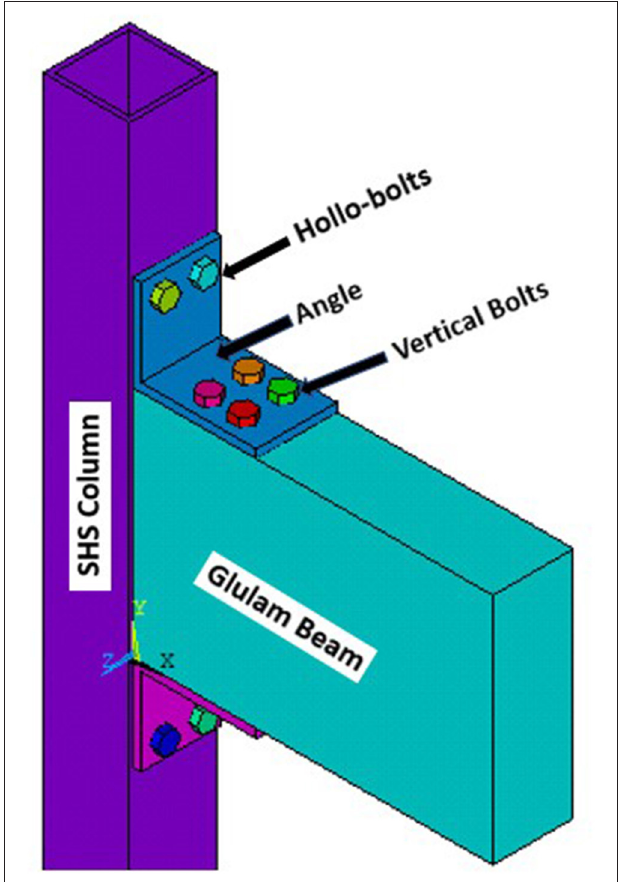
S j,ini > 25EI b / L b (unbraced frame)